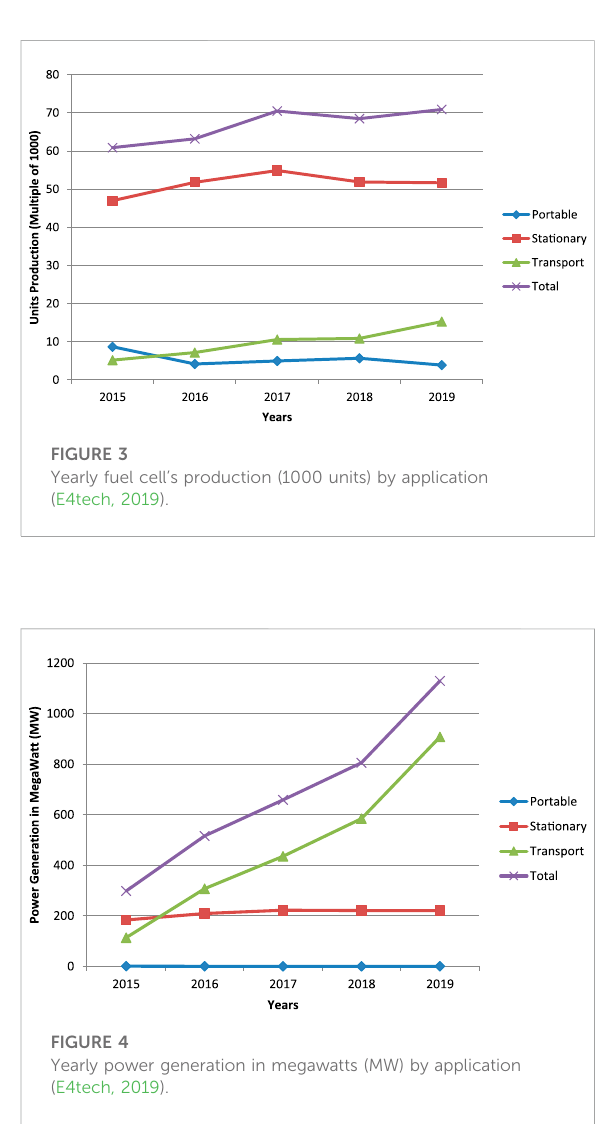
FIGURE 4 Yearly power generation in megawatts (MW) by application (E4tech,